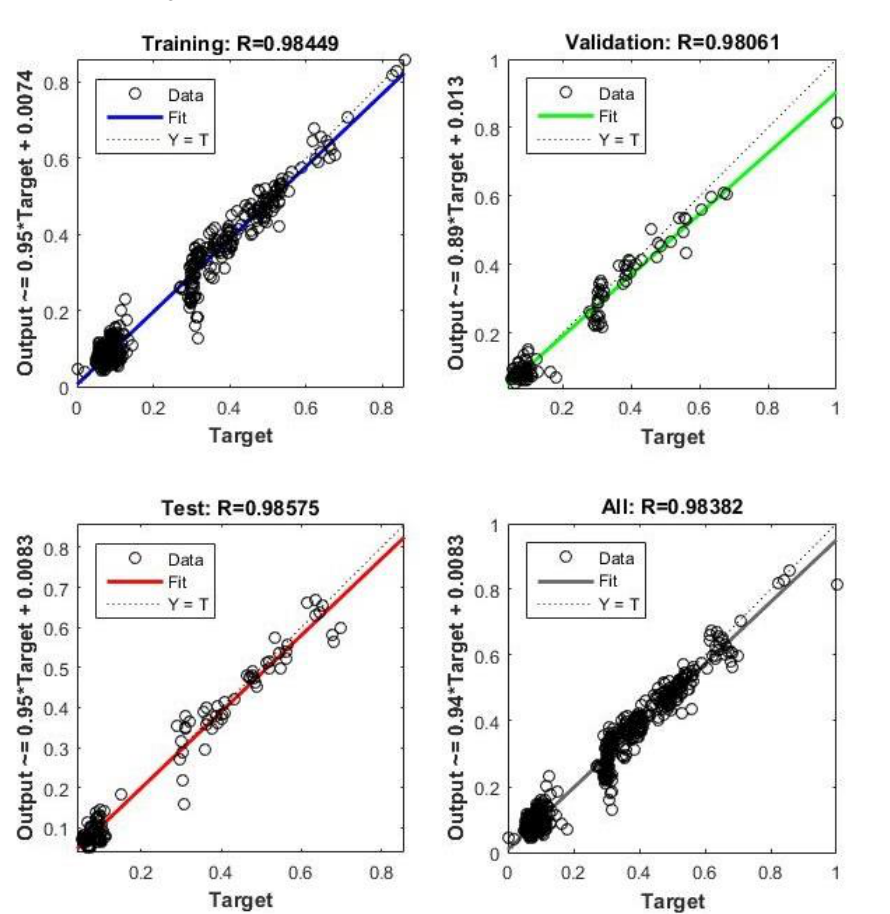
Figure 3. Correlation coefficient curves of the SWQM model.